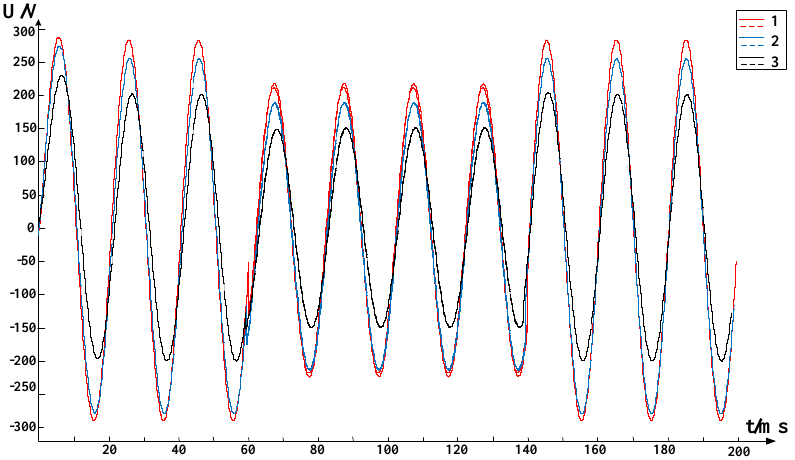
Figure 12. Comparison of adjacent load voltages of three cases.